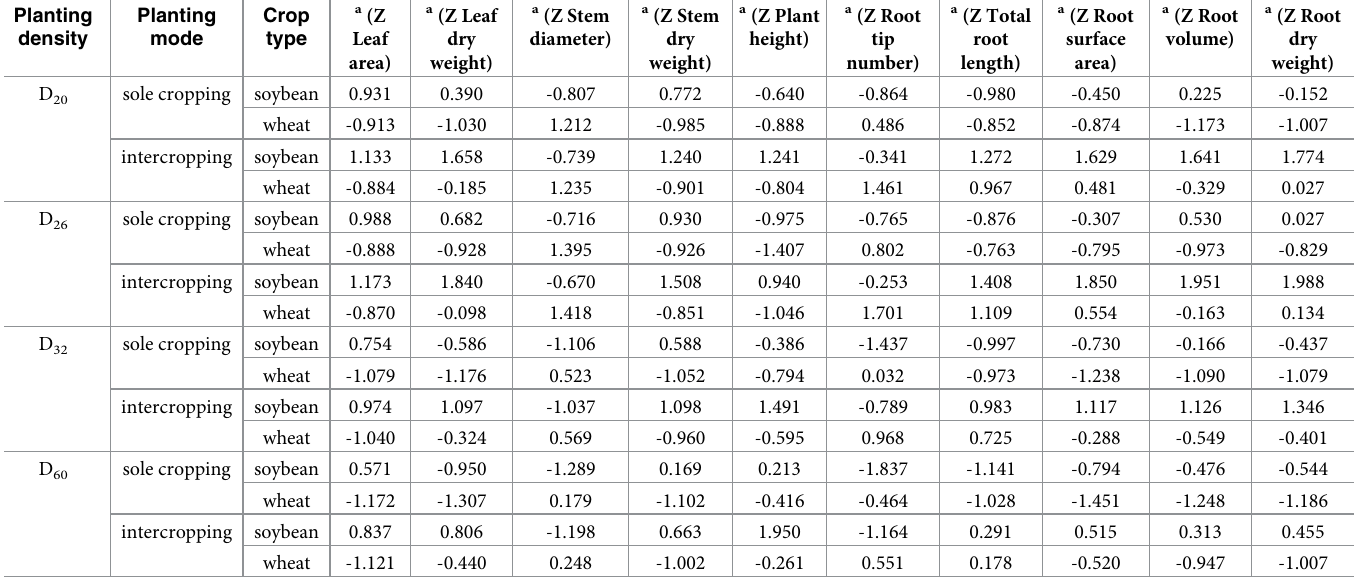
Table 1. Standardized data for population modules in soybean/wheat sole cropping and intercropping populations at normal nutrient level and different planting densities. Planting density